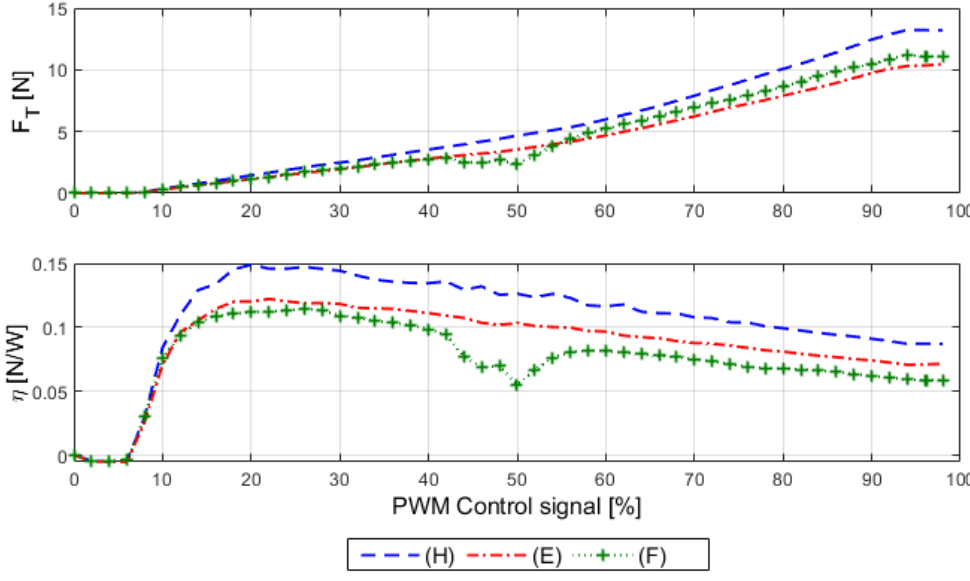
Figure 2. Performance comparison of faulty and undamaged rotors: thrust of a single motor–rotor unit ( top ) and achieved power efficiency ( bottom